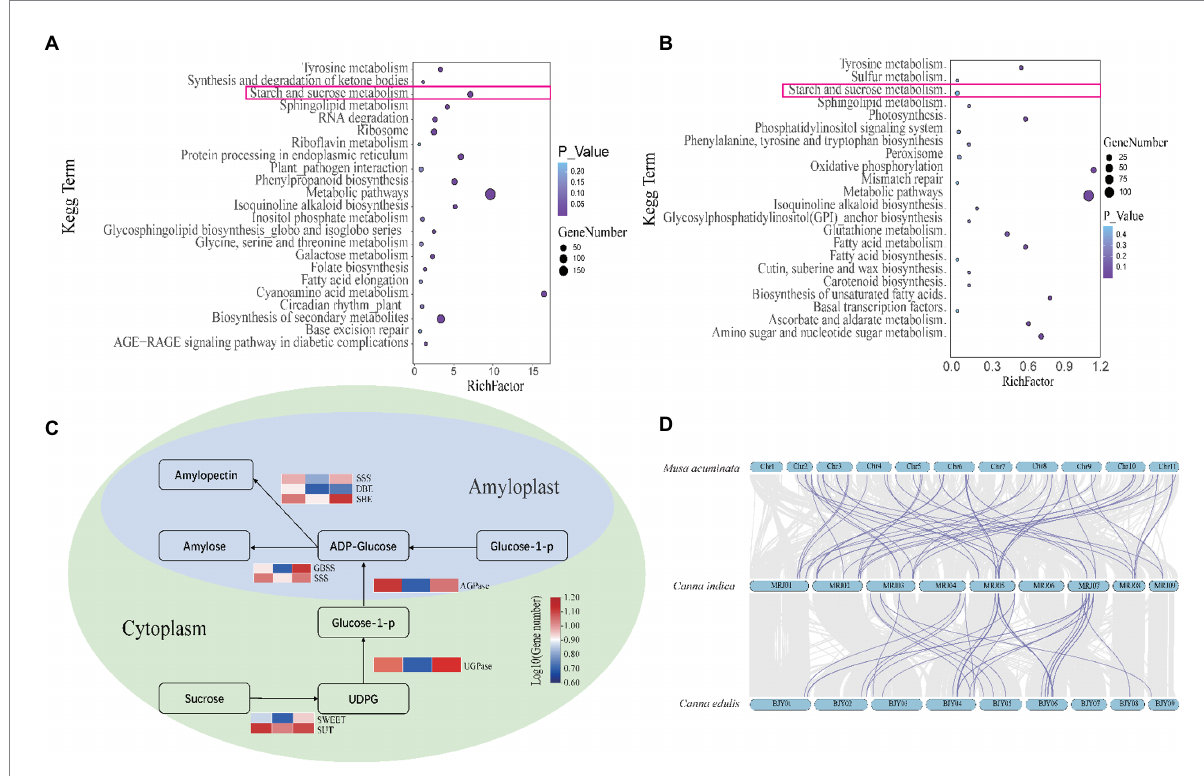
FIGURE 3 (A) Kyoto Encyclopedia of Genes and Genomes (KEGG) analysis of unique genes in Canna edulis . (B) KEGG analysis of unique genes in C. indica . (C) Comparison of gene copy numbers of C. edulis , C. indica , and M. acuminata in the pathways for starch and sucrose metabolism. (D) The gray area represents the collinearity block of C. edulis - C. indica and M. acuminata - C. indica . The purple line indicates that C. edulis and M.acuminata exhibited significantly expanded gene pairs, as compared to C. indica